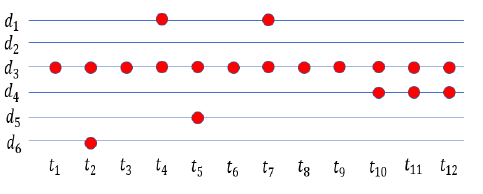
Figure 1. Example of clinical time series with six variables within 12 time steps. Red dots denote the observation